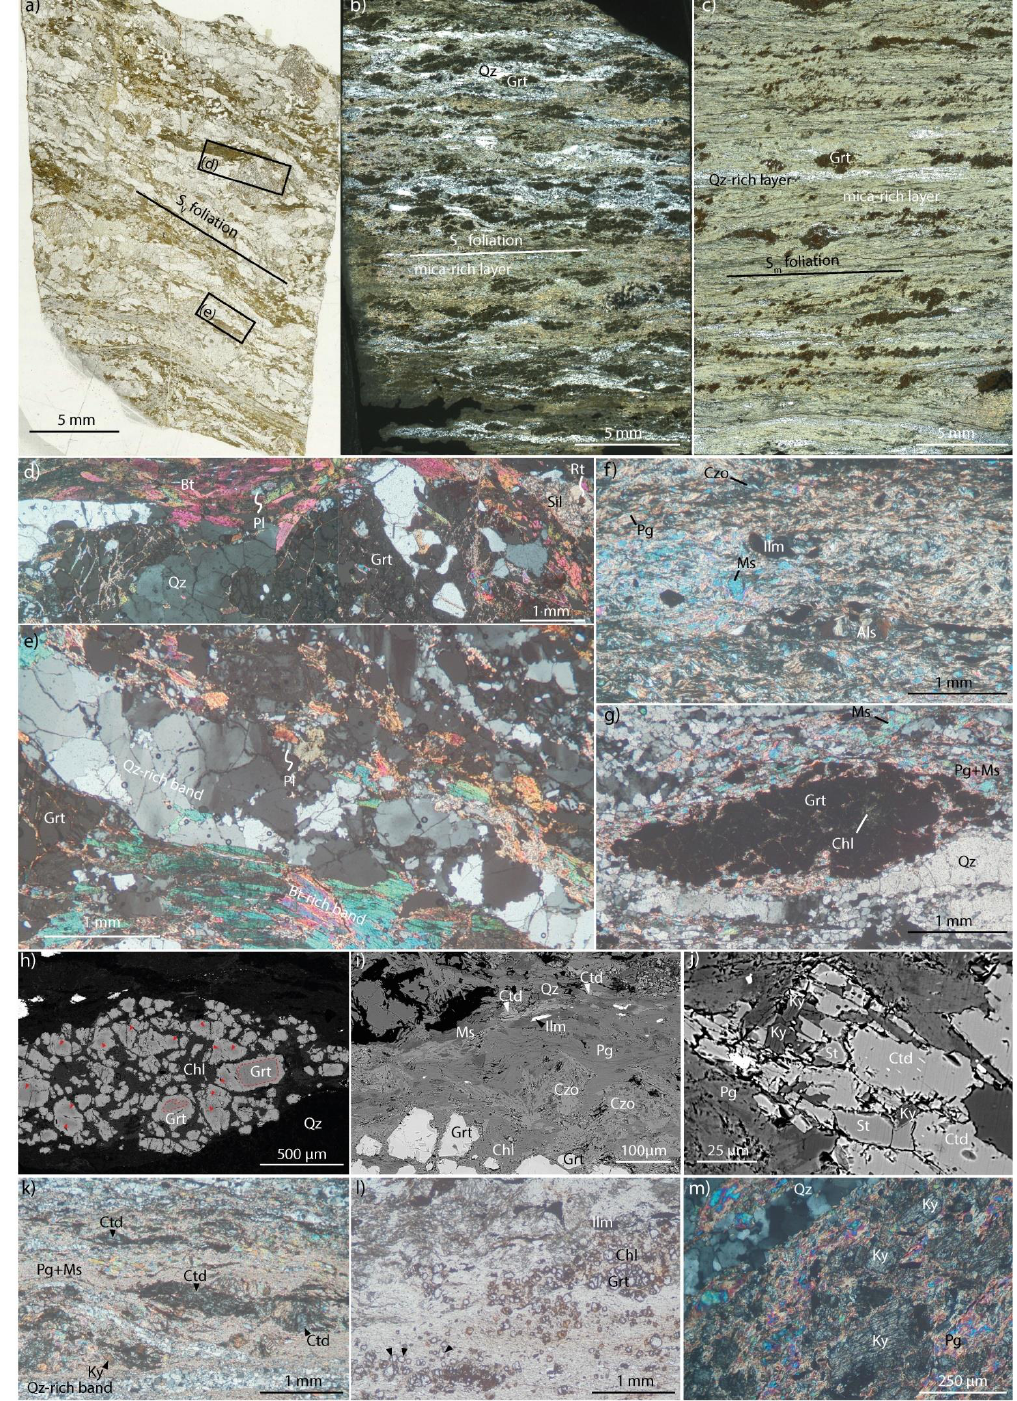
Figure 4. ( a – c ) Scanned thin sections of Grt-Sil migmatitic paragneiss (sample FCZ35) and Grt-Ctd mylonitic schists (samples FCZ39, FCZ43) under plane polarized light ( a ), hereafter PPL, and cross- polarized ( b , c ) light, hereafter CPL. ( d ) Microphotograph highlighting a Grt porphyroblast in a quartz- feldspathic layer, anastomosed by a Bt-Sil-rich one (sample FCZ35; CPL). ( e ) Quartz-feldspathic layer alternating to a Bt-rich one in sample FCZ35; note pinning microstructures and left-over grains of Qz indicating GBM recrystallisation; CPL microphotograph. ( f ) Detail of a mica-rich layer in sample FCZ39 where Pg and Ms occur together with Als; CPL microphotograph. ( g ) Lens-shaped garnet aggregate between a thin mica-rich band and Qz-rich bands; note SGR recrystallisation of Qz;